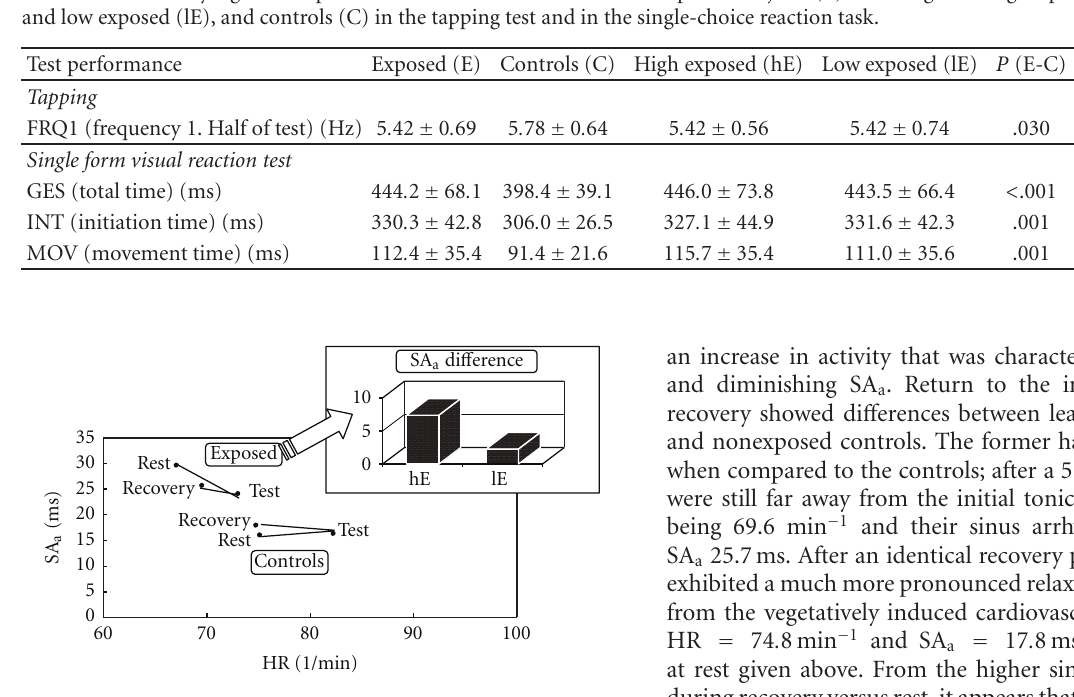
Figure 2: Absolute sinus arrhythmia (SA a ) versus heart rate (HR) in lead-exposed subjects (E) and controls (C) at the three stages of rest, “memory span for numbers” test, and recovery (vegetative pattern) as well as SA a di ff erentials between rest and recovery in the two subgroups of high-exposed (hE) and low-exposed (lE)